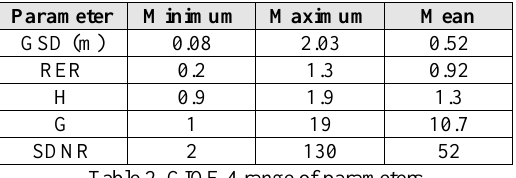
Table 2. GIQE 4 range of